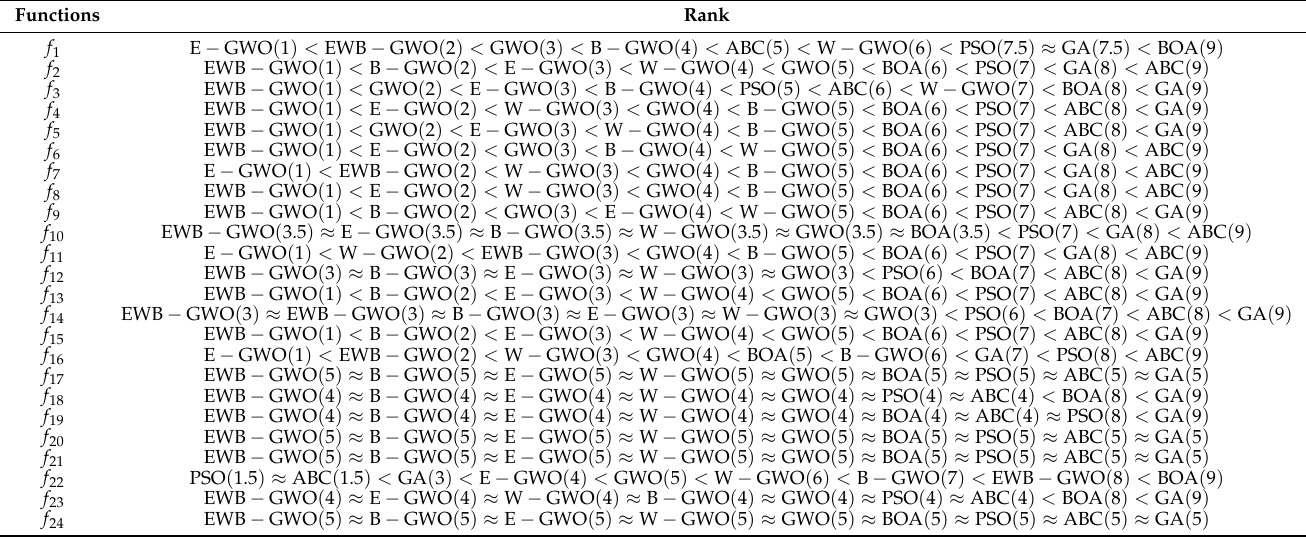
Table 8. Wilcoxon rank test order.